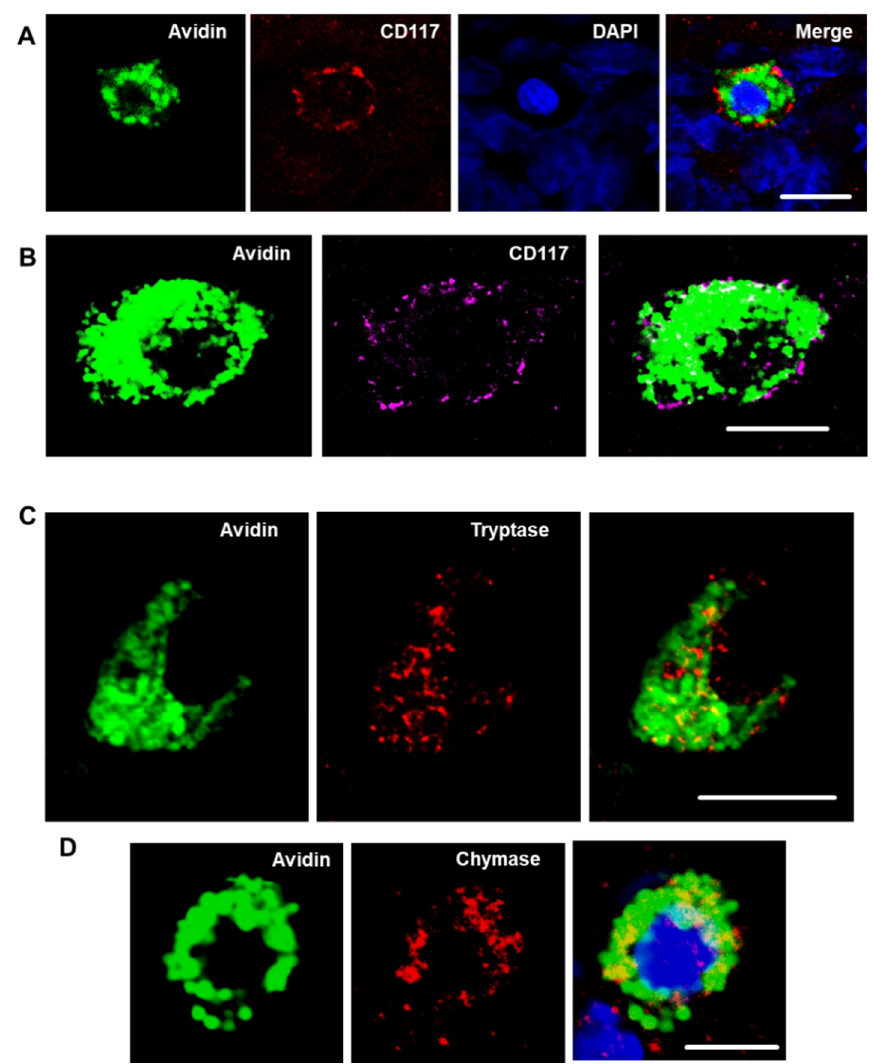
Figure 2. CD117, tryptase, and chymase are expressed by cochlear MCs. Representative confocal images of cochlear MCs that were immunopositive for CD117 (red / magenta) ( A , B ), tryptase (red) ( C ) and chymase (red) ( D ). MCs were detected with Alexa Fluor ® 488-conjugated avidin (green). Nuclei in A and D were counterstained with DAPI (blue). Images depicted from the modiolus region of medial turn from p3 rat cochlea. Images A – C were obtained from p3 Wistar rats; image D was obtained from p30 mouse. Scale bars 10 µm.